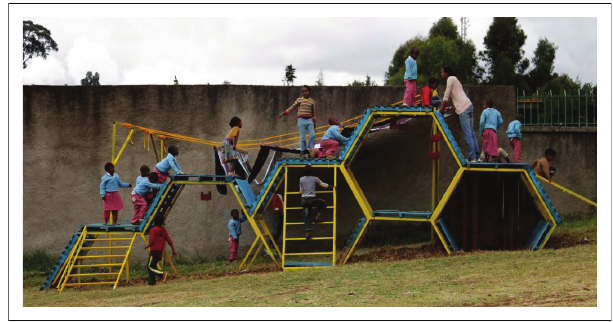
FIGURE 2: Example of photovoice to illustrate physical